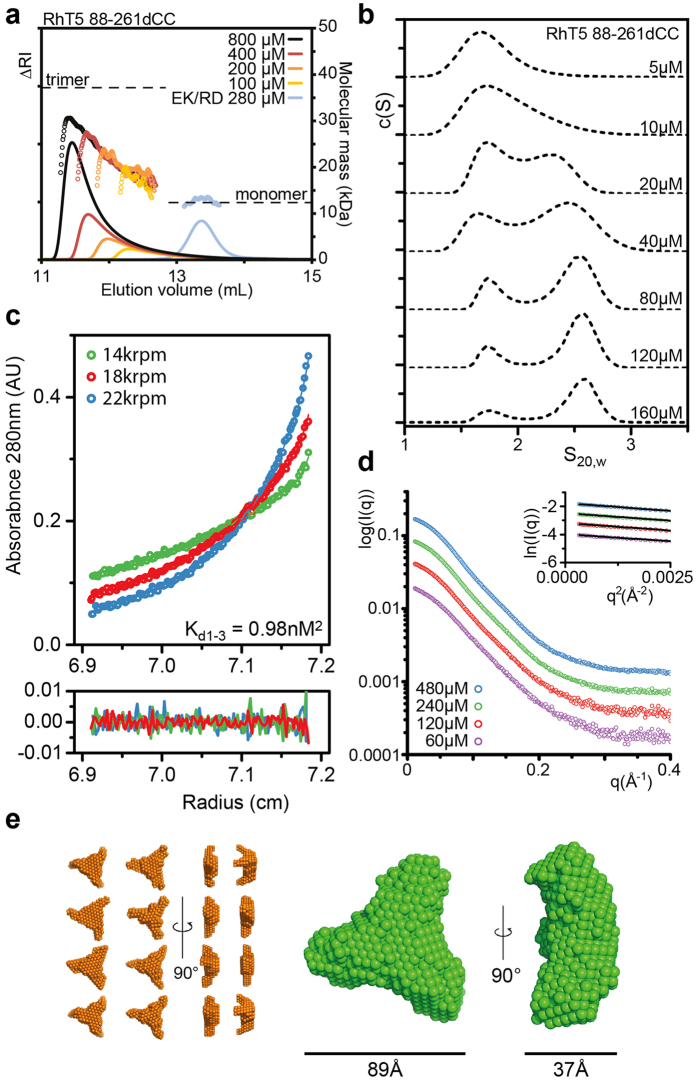
Trim5α coiled-coil contributes to assembly (a) SEC-MALLS analysis of RhT5 88–261dCC shows an increase in elution position and Mw with increasing concentration. (b) SV-AUC c(S) analysis of RhT5 88–261dCC over a concentration range of 5–160 μM. Normalised c(S) profiles are shown. (c) (upper) Multispeed SE-AUC of RhT5 88–261dCC. Data were collected at three starting concentrations and fit taking into account time and radially independent noise. A single starting concentration (20 μM) is shown. (lower) Residuals of the fit to a monomer-trimer equilibrium with dissociation constant of 0.98 nM2. (d) SAXS curves between 60–480 μM with guinier curves inset. (e) ab initio models of the RhT5 88–261dCC trimer were produced using DAMMIF36. Selected raw models are shown in orange, consensus averaged model generated in DAMAVER is shown in green.